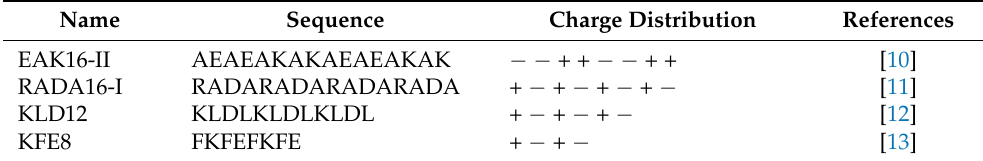
Table 1. Some classical ionic complementary self-assembling